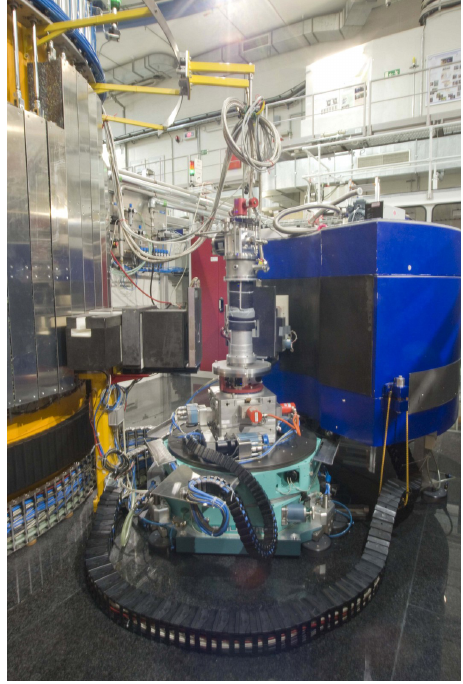
Figure 1: Instrument PUMA (Copyright by W. Schürmann,